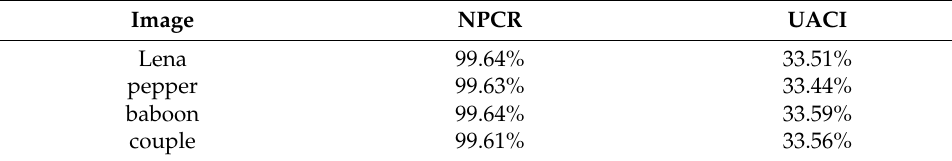
Table 2. NPCR and UACI of different